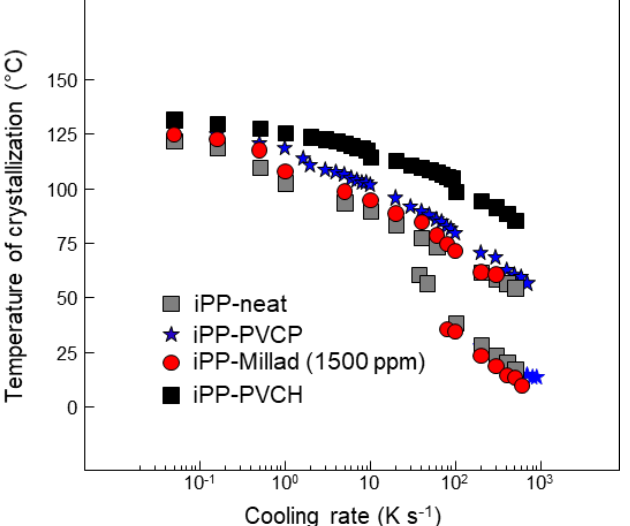
Figure 9. Crystallization temperature (Tc) as a function of cooling rate for a non-nucleated (neat) iPP homopolymer (grey squares), two iPP homopolymers with pre-polymerized nucleating polymers, PVCP (blue stars) and PVCH (black squares), and one conventionally nucleated iPP homopolymer with DMDBS (red circles; data are a combination of results in [72] and previously unpublished data).